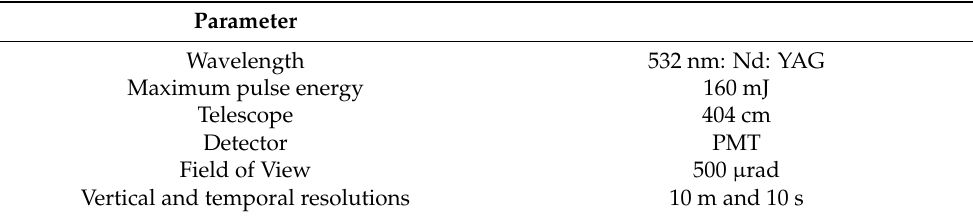
Table 1. UZ lidar Table 1. UZ lidar specification.